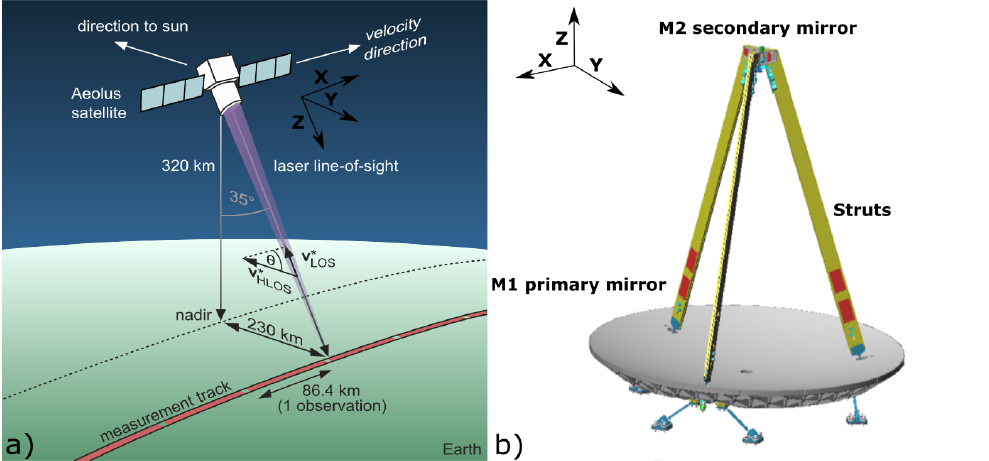
Figure 1. (a) Aeolus observational geometry (adapted from Lux et al., 2020b) and (b) the setup of the Aeolus telescope consisting of the M1 primary and M2 secondary mirrors and the mounting struts (adapted from https://directory.eoportal.org/web/eoportal/satellite-missions/ a/aeolus, last access: 23 August 2021).